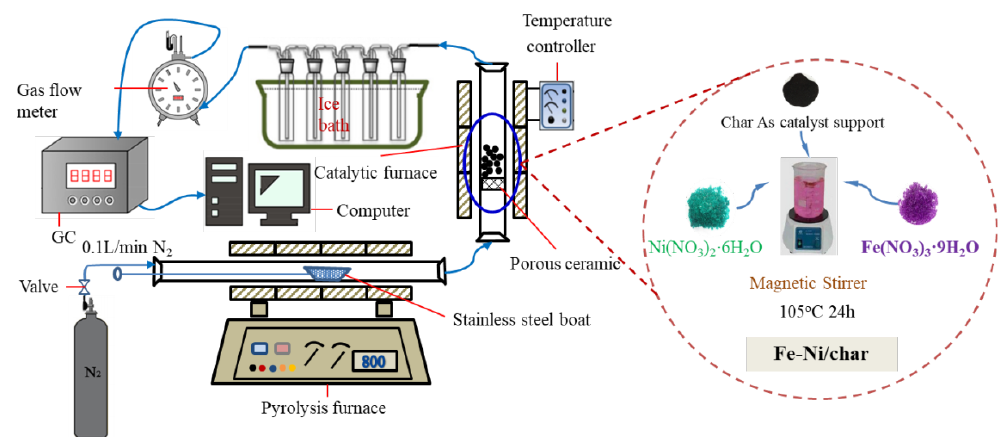
Figure 1. Schematic diagram of ex situ catalytic pyrolysis system.